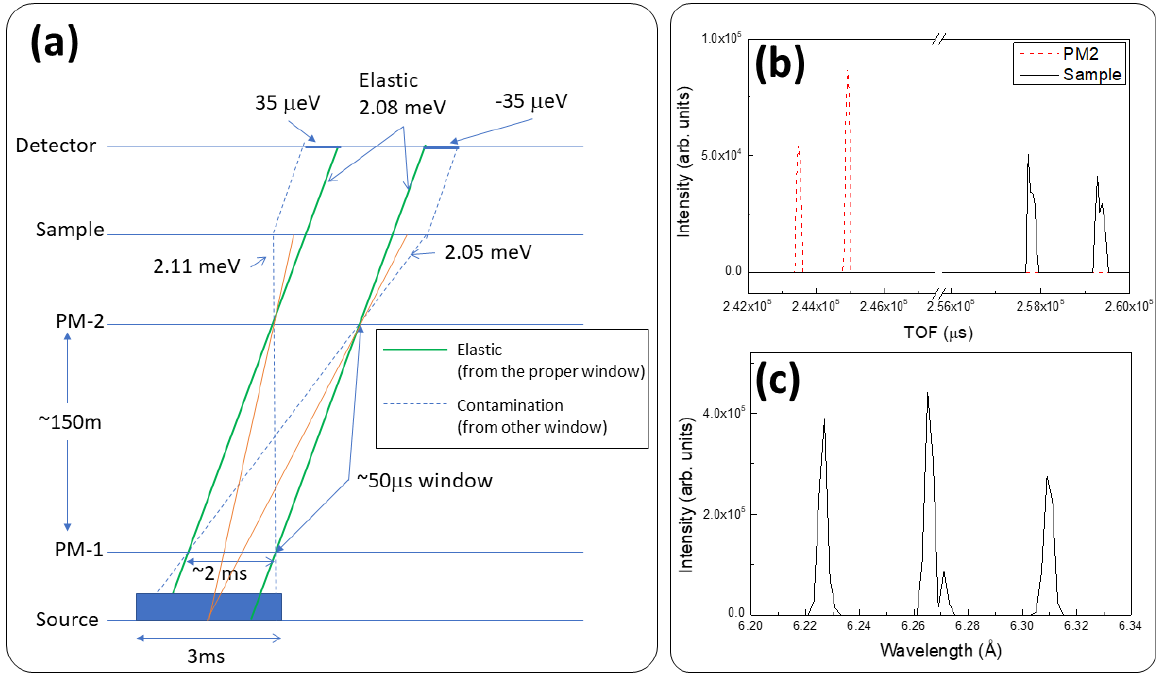
Figure 4. ( a ) Time diagram showing the generation of two pulses out of the long ESS pulse and the predicted satellite contaminant neutrons; ( b ) Time-of-flight and ( c ) wavelength spectrum calculated with the conditions described in ( a ), with the fast choppers running at f = 308 Hz.